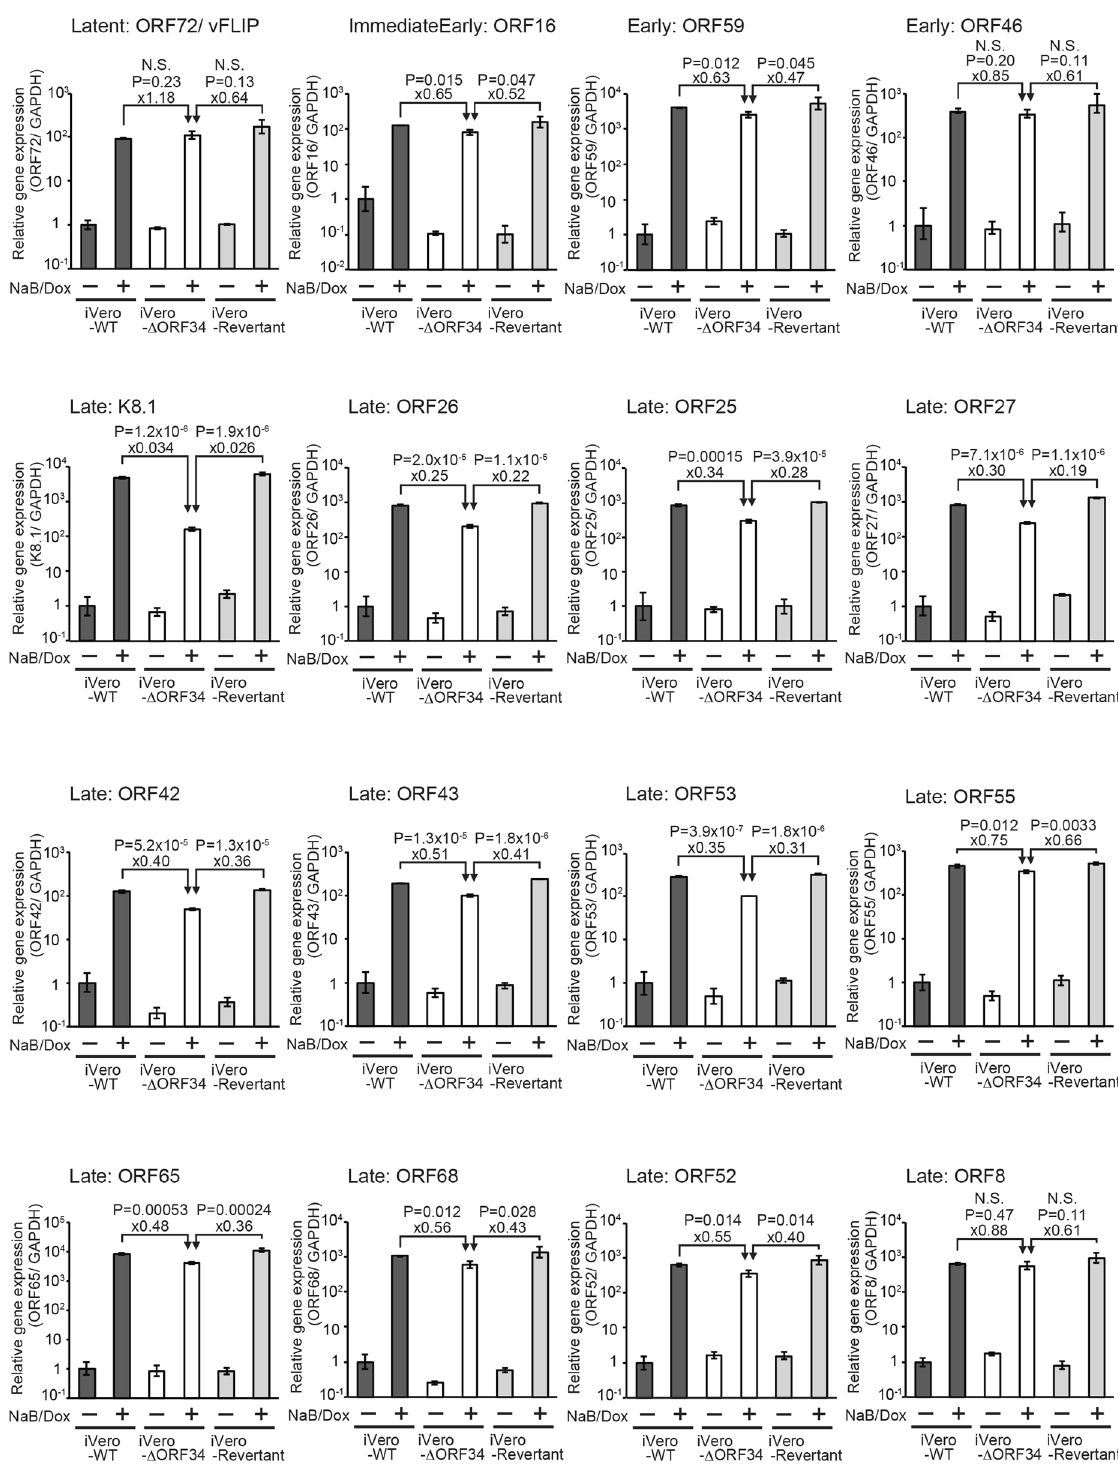
Figure 3. ORF34 is required for the late gene expression but not for latent, IE, and E genes expression. The iVero-WT, iVero- Δ ORF34, and iVero-Revertant cells were cultured in media with/or without NaB and Dox to induce a lytic state. Total RNA was extracted from cells and subjected to RT-qPCR. The mRNA expression levels of viral genes, latent: ORF72 (v-cyclin); IE: ORF16 (vBcl-2); E: ORF46 (uracil DNA glycosylase) and ORF59 (viral DNA polymerase processivity factor); L: K8.1 (glycoprotein), ORF26 (capsid protein), ORF25 (capsid protein), ORF27 (putative glycoprotein), ORF42 (unknown tegument protein), ORF43 (capsid protein), ORF53 (glycoprotein), ORF55 (unknown tegument protein), ORF65 (capsid protein), ORF68 (glycoprotein), ORF52 (capsid protein), and ORF8 (glycoprotein), were normalized by GAPDH expression. Expression levels were assessed using three independent samples, and error bars indicate ± standard